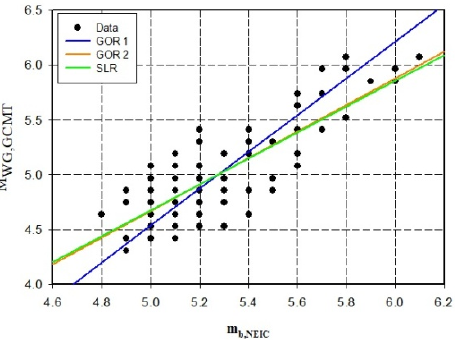
Figure 9. The (m b,NEIC − M wg ) data, as well as the GOR1, GOR2, and SLR regression lines.